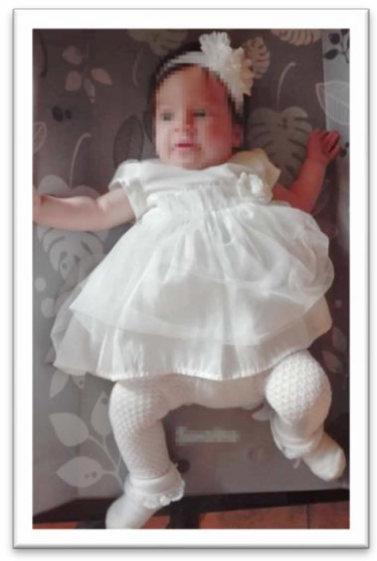
Figure 1. Asymmetrical tonic neck reflex (ATNR) expression in an